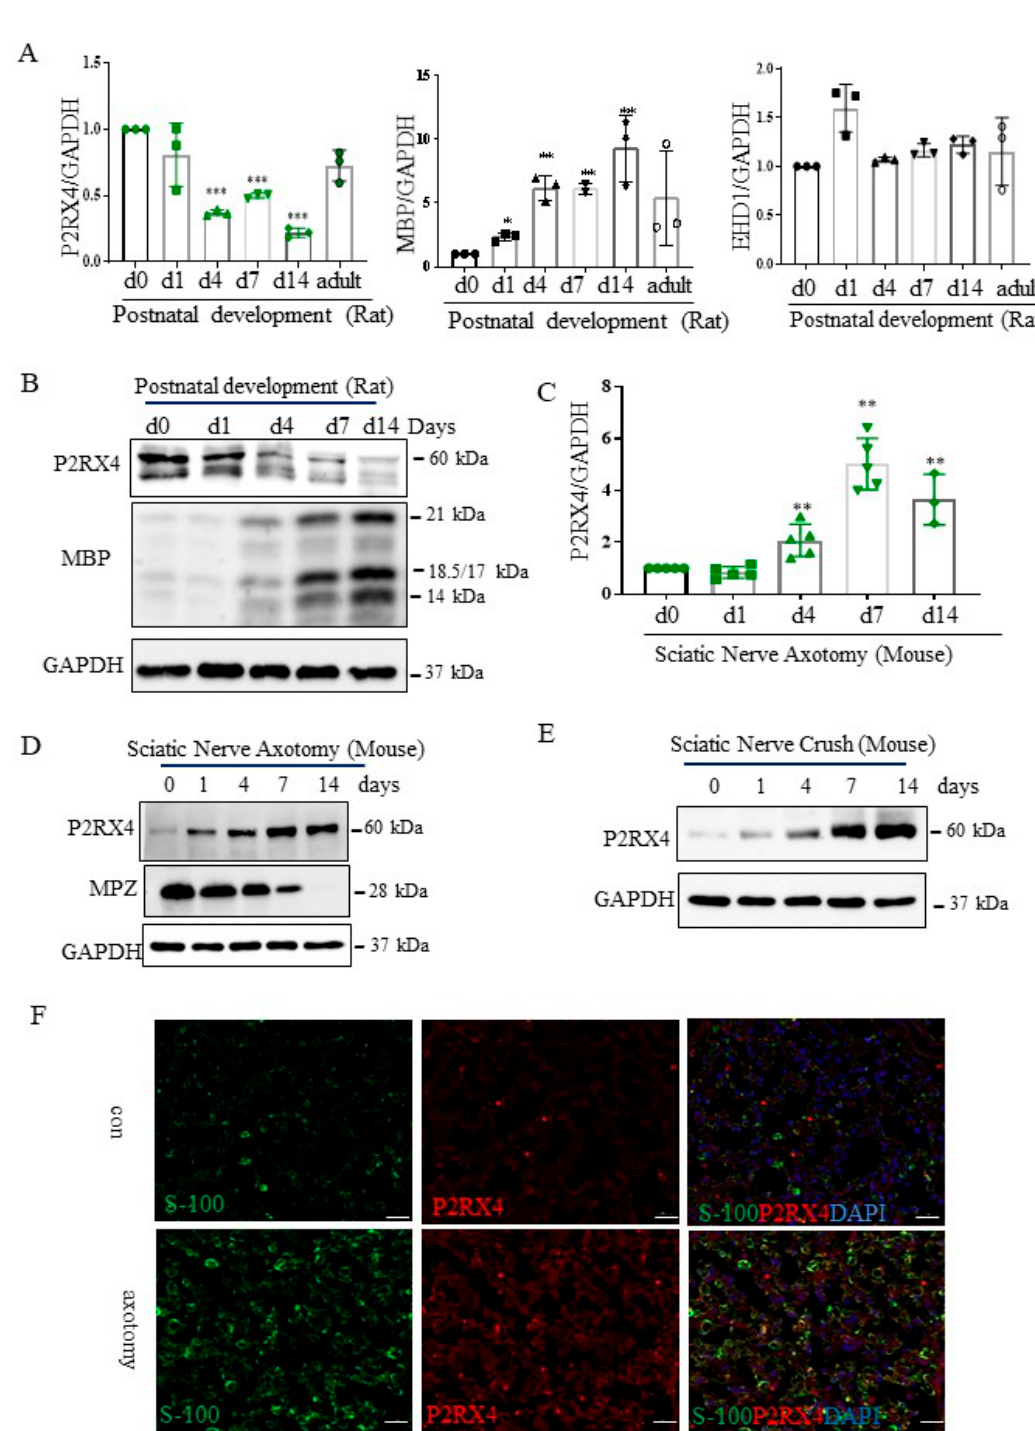
Figure 3. P2RX4 as differentially regulated during postnatal development and after sciatic nerve injury in vivo. P2RX4 mRNA (( A ), n = 3) and protein ( B ) levels were downregulated during postnatal development. MBP was used as a positive control. P2RX4 mRNA (( C ), n = 5) and protein ( D ) levels increased after axotomy. ( E ) The P2RX4 protein level decreased after mouse crush injury. Data are the mean ± SD. * p < 0.05, ** p < 0.01, *** p < 0.001. ( F ) Colocalization of P2RX4 (green) and S100 (red) 7 days after sciatic nerve injury. A transverse section of a mouse sciatic nerve was stained. Scale bar = 20 µ m.